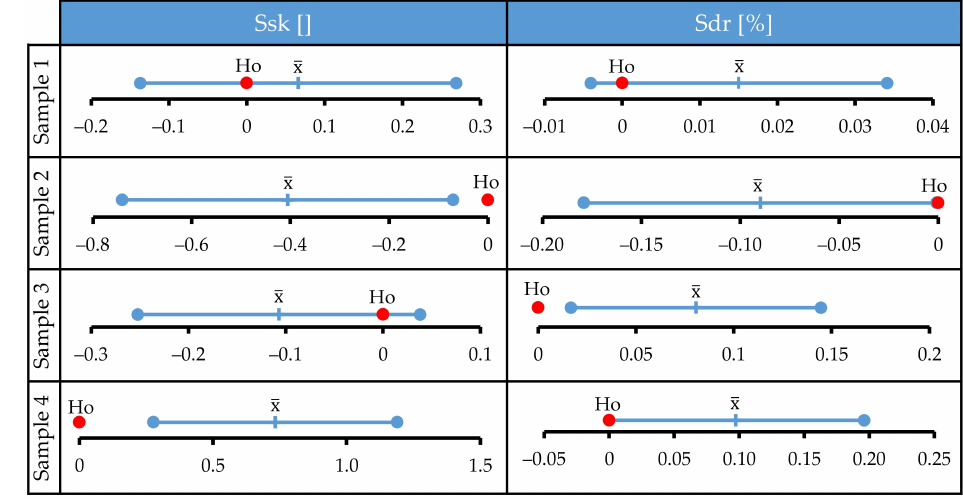
7Figure 7. Results of a paired t test: statistical analysis of the changes in Ssk and Sdr parameters Figure determined on areas of 10 × 10 µ m before and after the corrosion tests of all